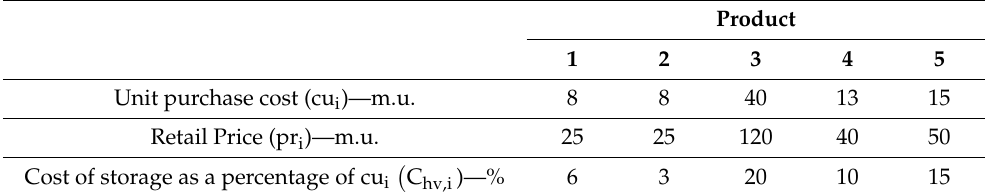
Table 6. Parameters related to product typology.